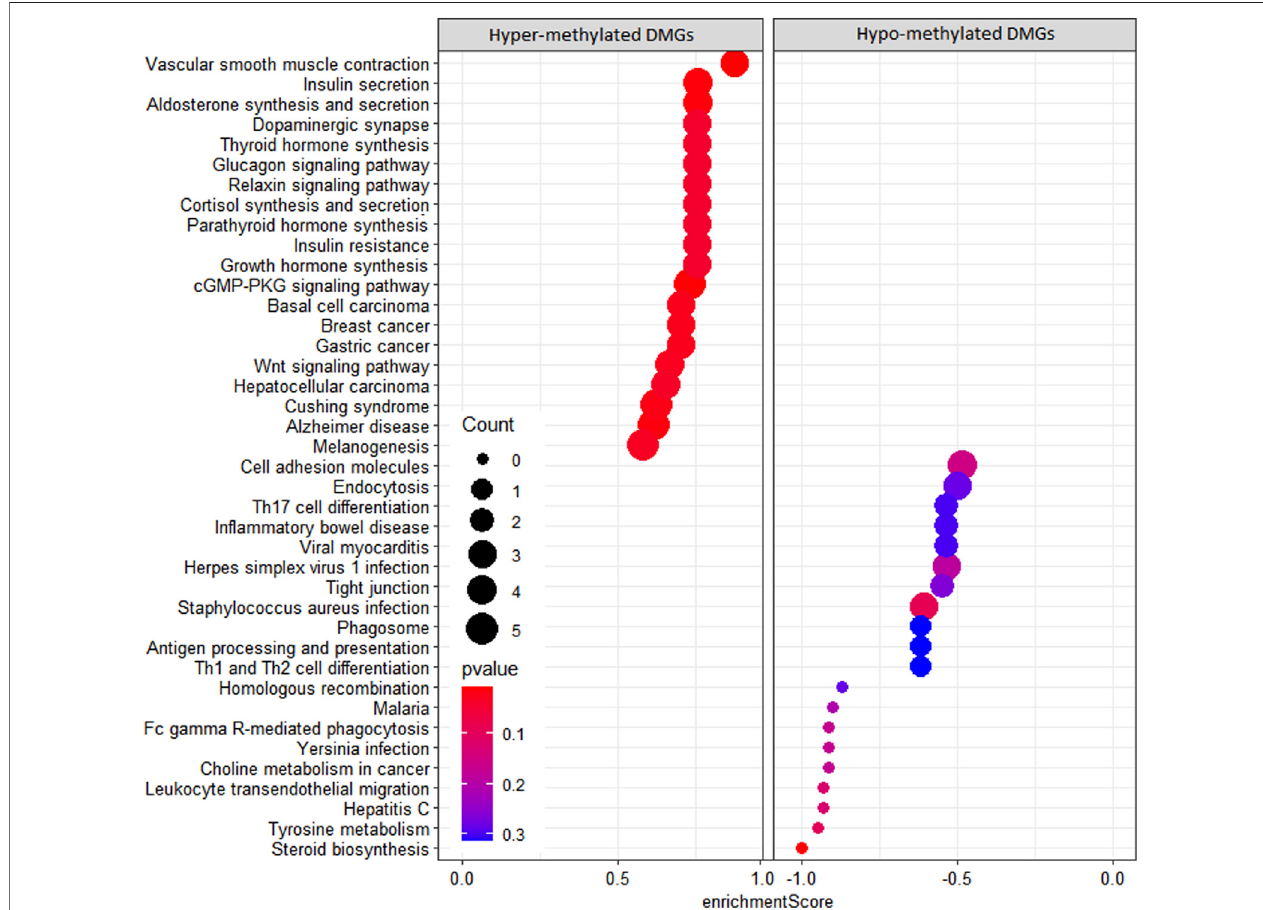
FIGURE 4 | Dot plot of KEGG pathways enriched by hypermethylated and hypomethylated